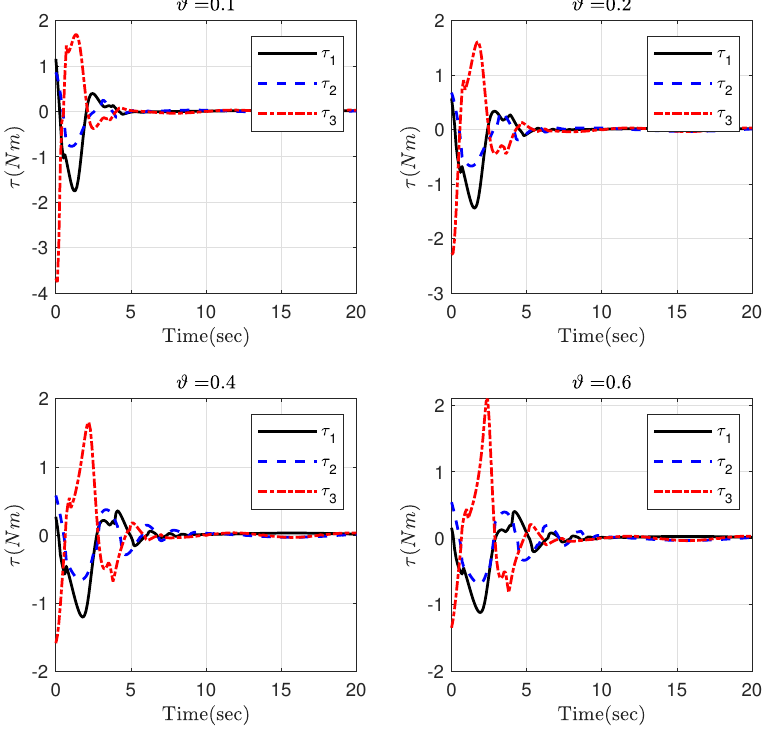
Figure 14. The control torque in Part 2 for different ϑ